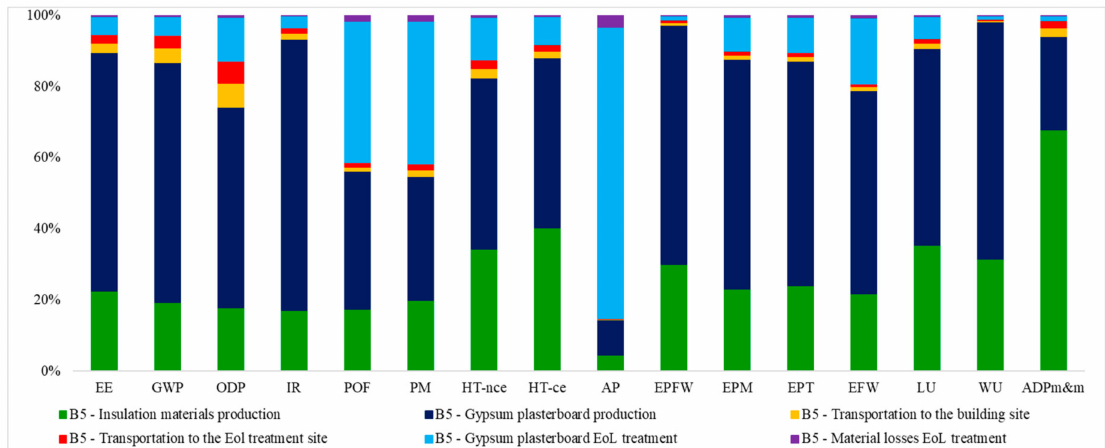
Figure A1. Contribution of the different life cycle phases to the B5 module impacts—CfS